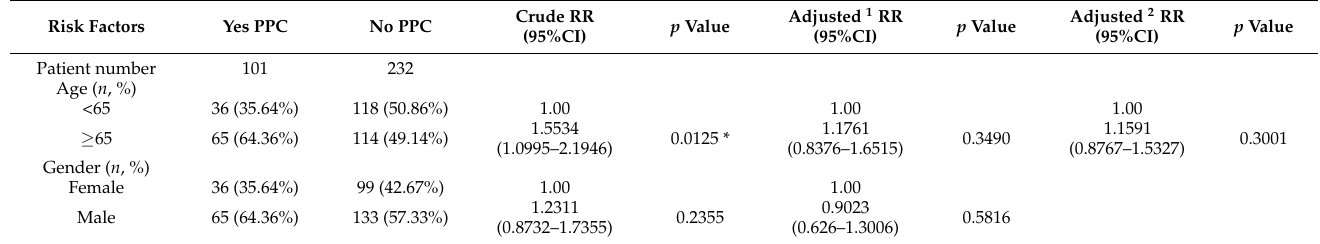
Table 5. Multivariate analysis for risk factors for postoperative pulmonary